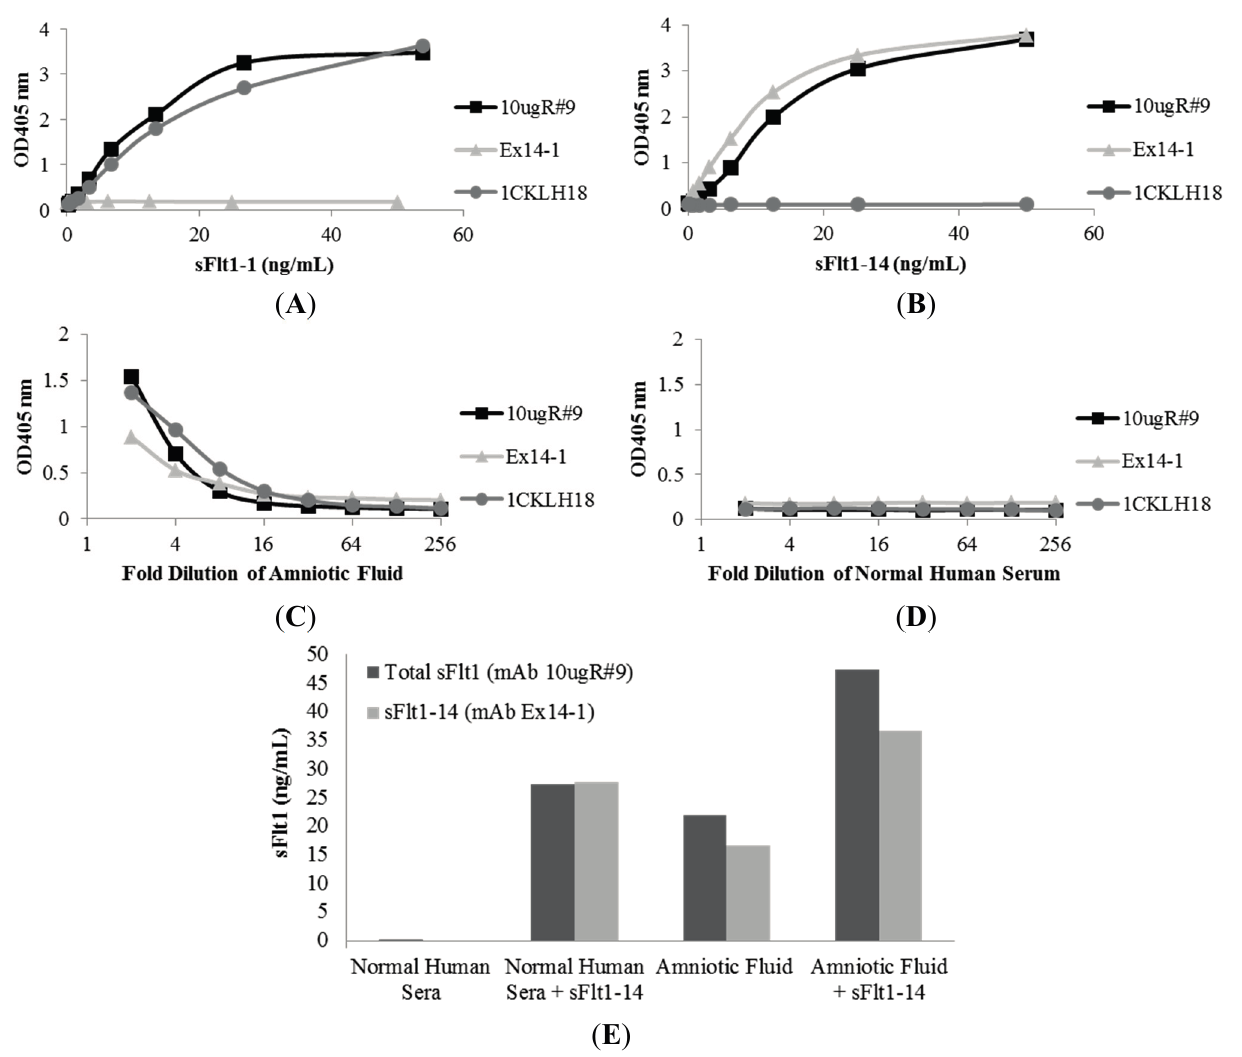
Figure 3. Mouse mAbs were specific for sFlt1 splice variants as measured by capture ELISA. Total sFlt1-specific mAb, 10ugR#9, recognized both recombinant sFlt1-1 ( A ) and sFlt1-14 ( B ) splice variants with similar sensitivity; however, mAb 1CKLH18 only detected sFlt1-1 while mAb Ex14-1 only detected sFlt1-14. In addition, each mAb specifically recognized endogenous sFlt1 present in amniotic fluid ( C ), while biological fluid that does not contain sFlt1 (normal human serum) was not detected ( D ). To assess interference of quantitation in biological fluids ( E ), 25 ng/mL of recombinant sFlt1-14 was spiked into normal human sera or amniotic